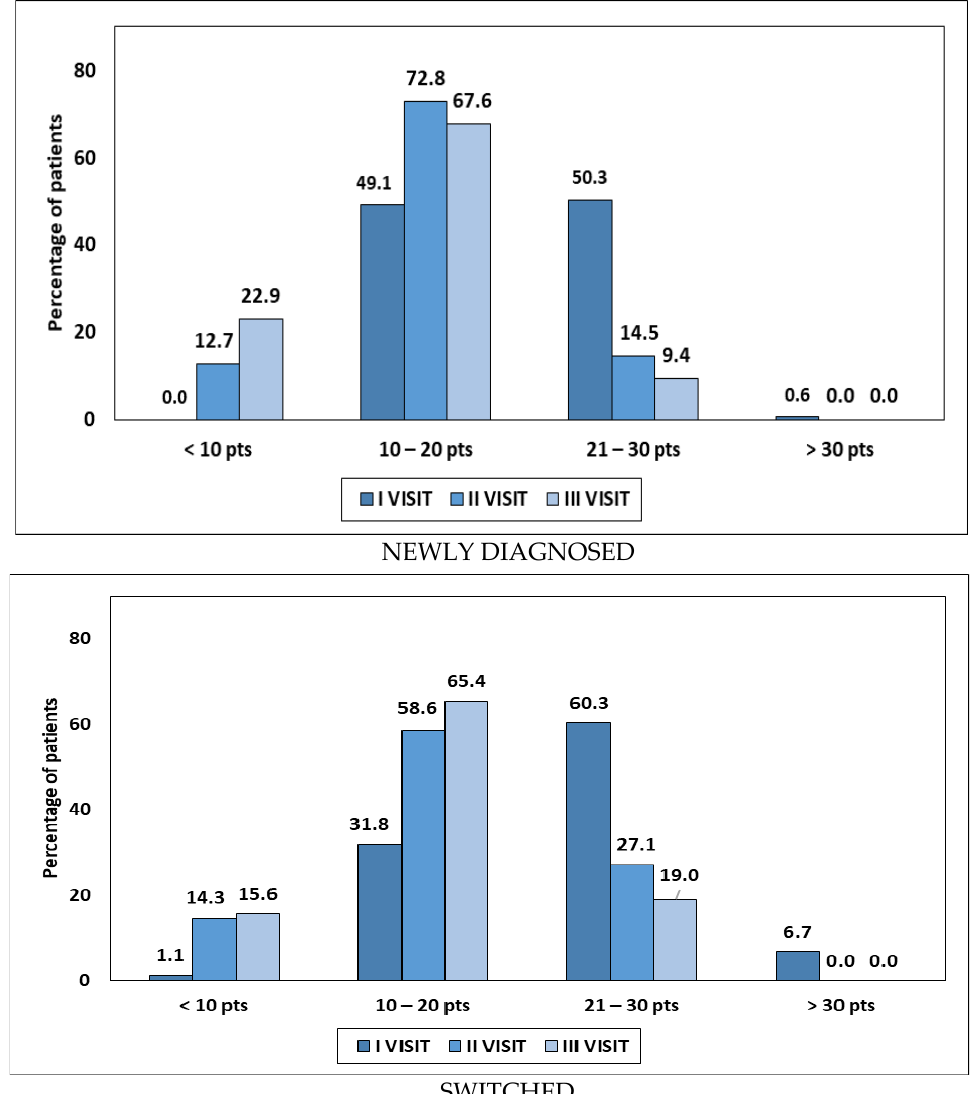
Figure 1. COPD assessment test (CAT) obtained across 3 visits in the subgroups of newly diagnosed and switched from other inhalators ( p < 0.001; χ 2 for trend).